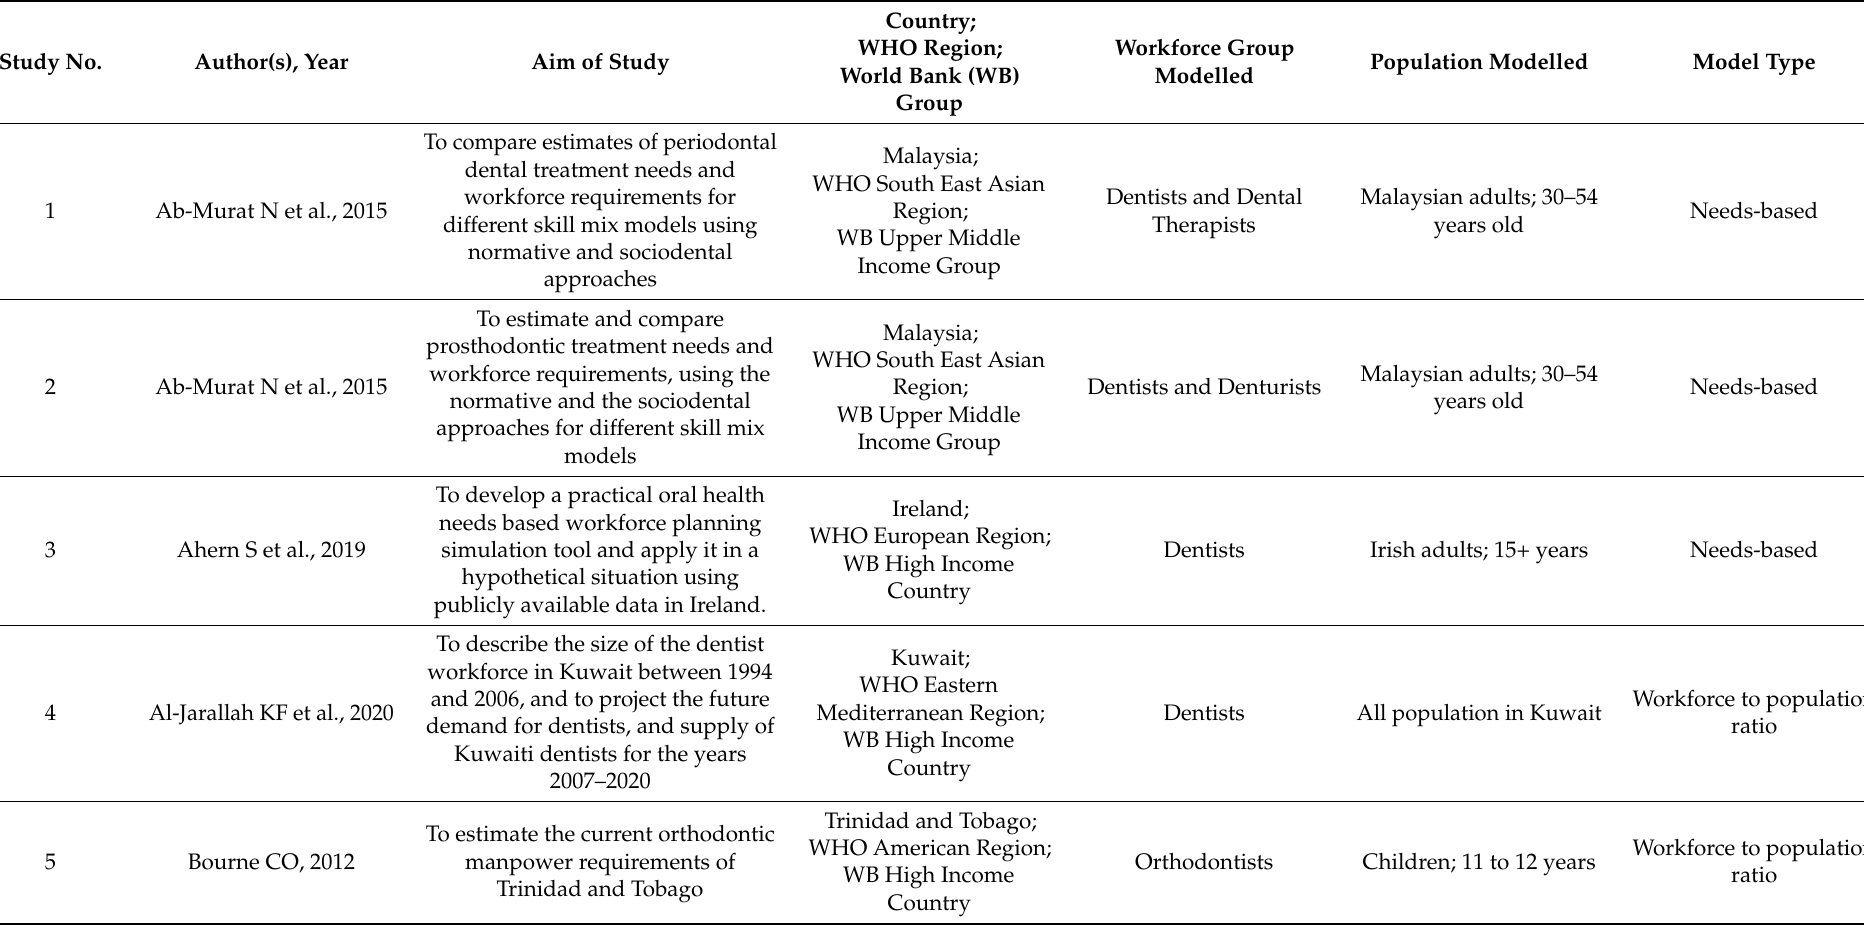
Table 1. Main characteristics of selected studies in the rapid